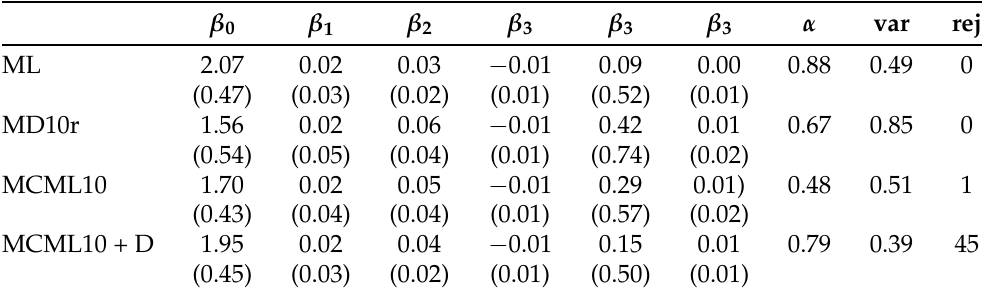
Table 5. Bootstrap coefficient means and standard errors of the ML, MDE10r, MCML10, and MCML10 + D estimators of the negative binomial (NB) regression for length of stay data ( n = 92); var is the total variance; rej is the number of rejected samples.